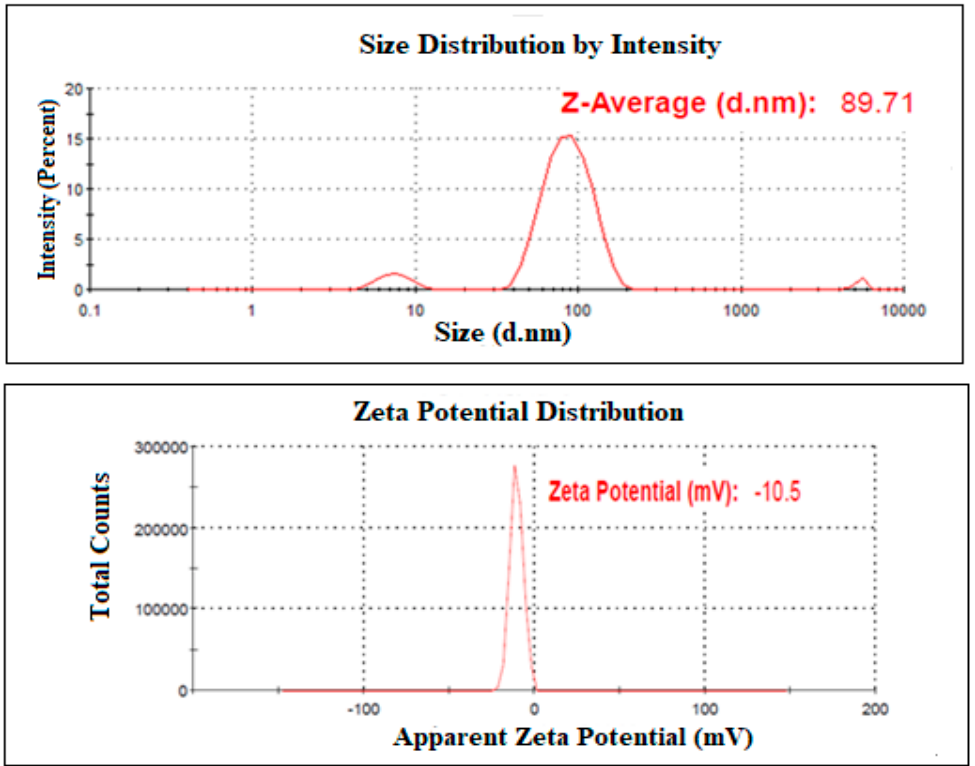
Figure 5. Representative data of globule size distribution and zeta potential of NAR-NE.